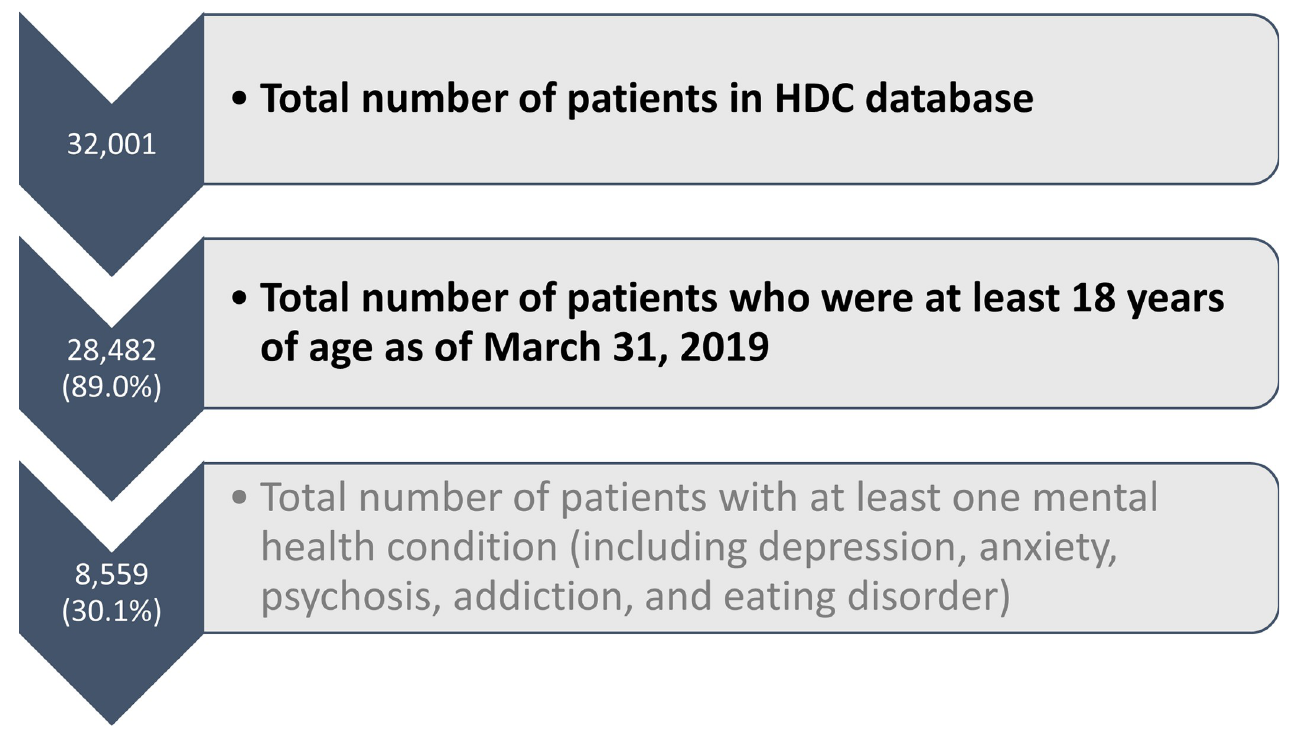
Fig 1. Primary cohort generation (step 1–2, general adult population) and secondary cohort generation (step 3, patients with a mental health condition) in the Health Databank